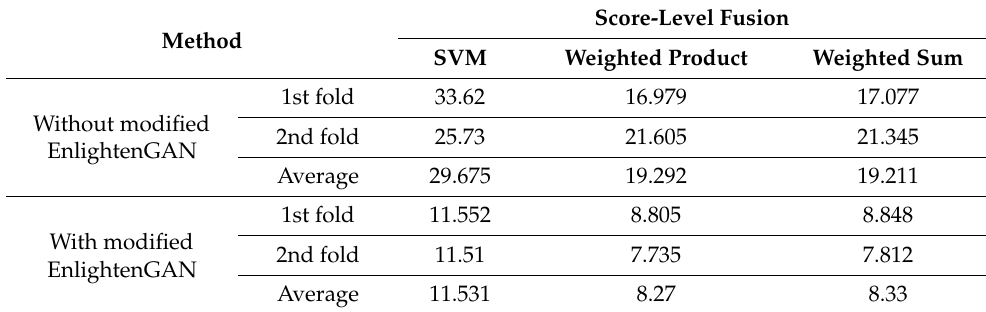
Table 9. Comparisons of EER for score-level fusion with or without modified EnlightenGAN (unit: %).